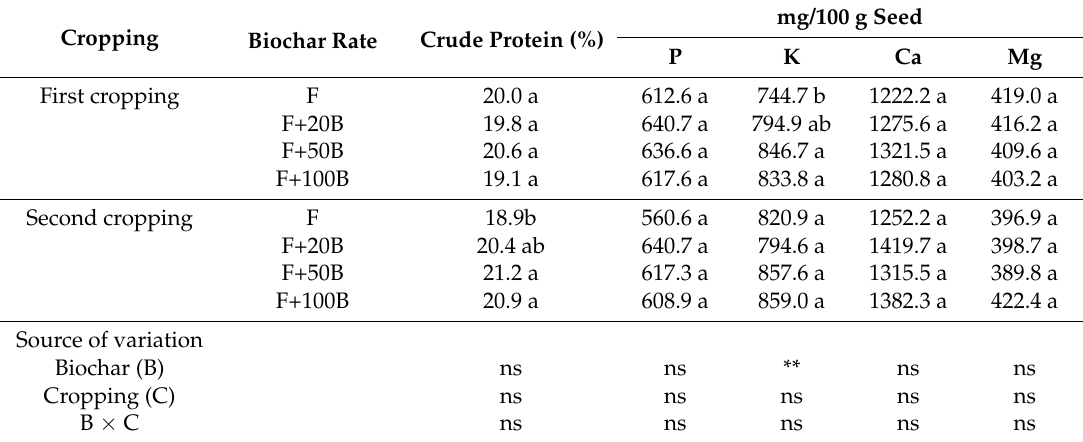
Table 3. The seed macronutrient mineral nutrient contents of sesame seeds under the different biochar treatments in different cropping after harvesting.